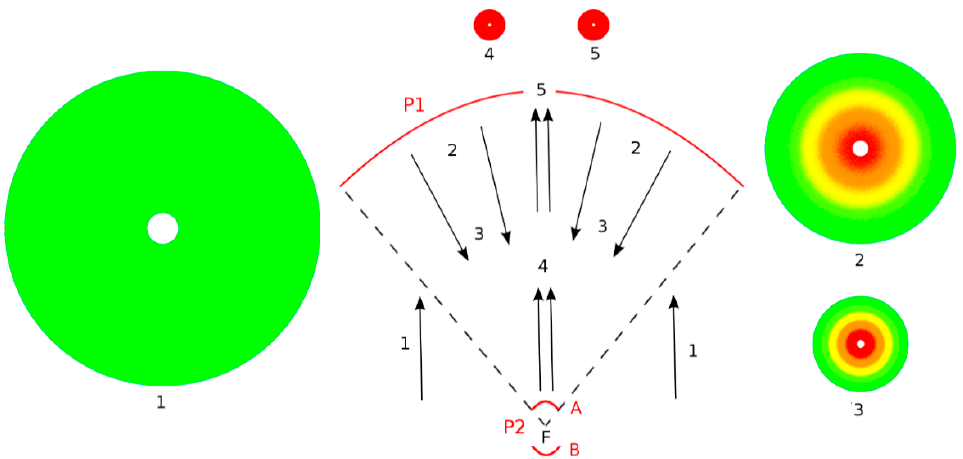
Figure 12. Flux measured for input parallel rays (1), after first reflection (2 and 3), after second reflection (4 and 5), in a device with two paraboloids (P1 and P2), with the same focal point. The second paraboloid can be convex, before the focal point (layout A) or concave, after the focal point (layout B). The flux relative colour scale goes from blue (cold) to red (hot).